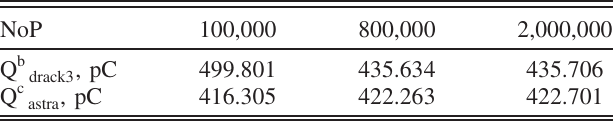
TABLE II. Numerical convergence study by varying the number of macro-particles (NoP) a .